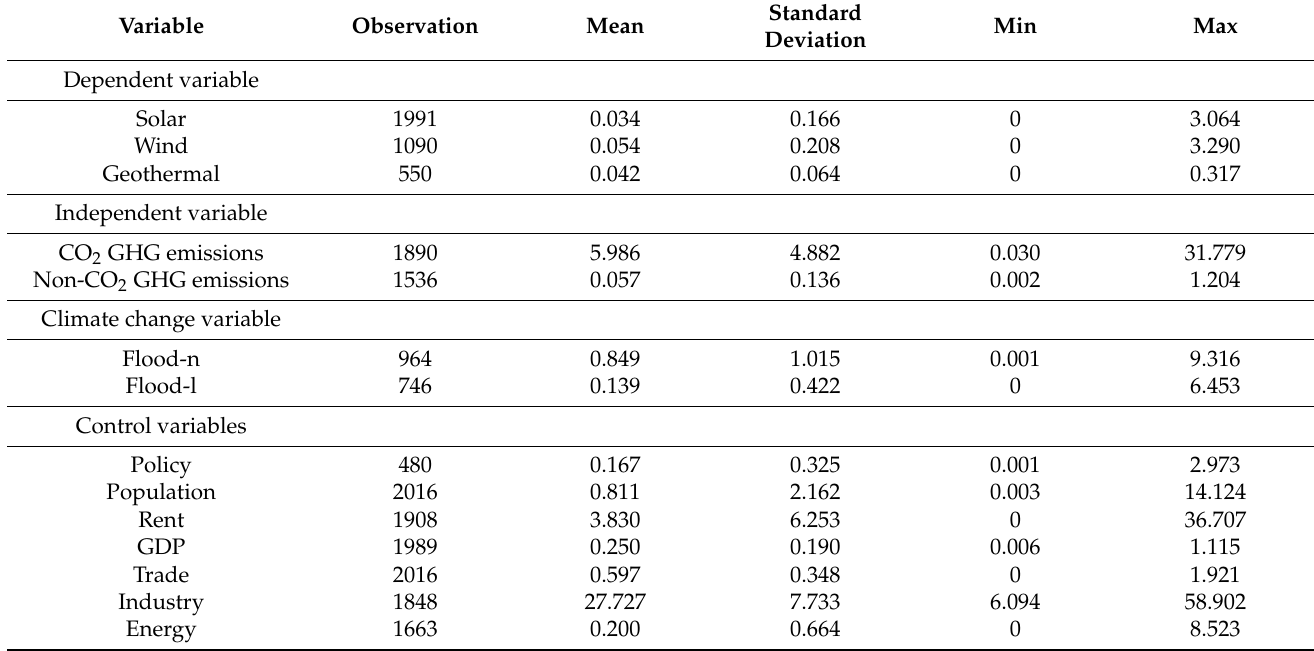
Table 1. Descriptive statistics of the